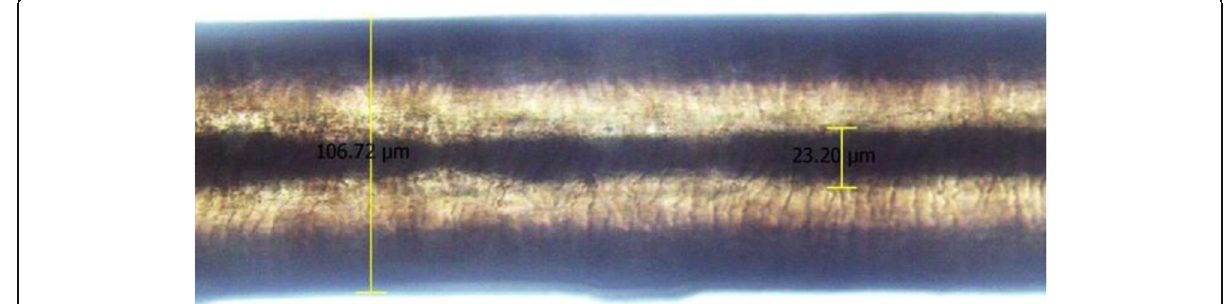
Fig. 2 Measurement of hair width (HW) and medullary width